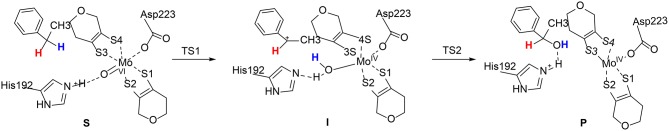
Suggested mechanism for molybdenum-dependent ethylbenzene dehydrogenase (Szaleniec et al., 2014). Copyright© 2014 Elsevier Inc.